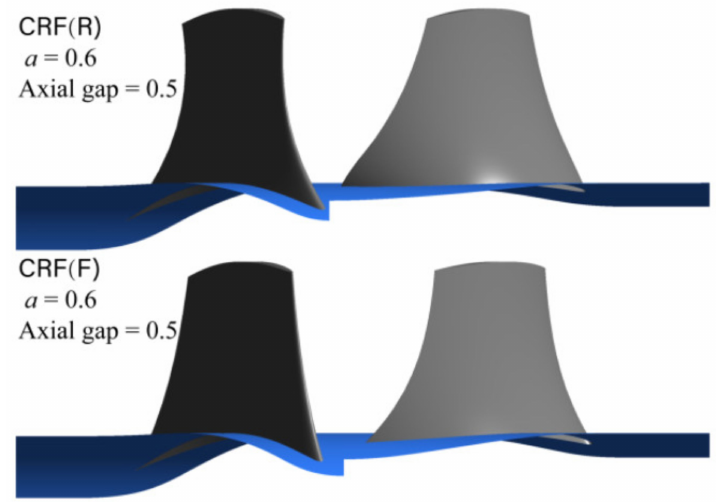
Figure 10. The distance between the FR TE and RR LE.